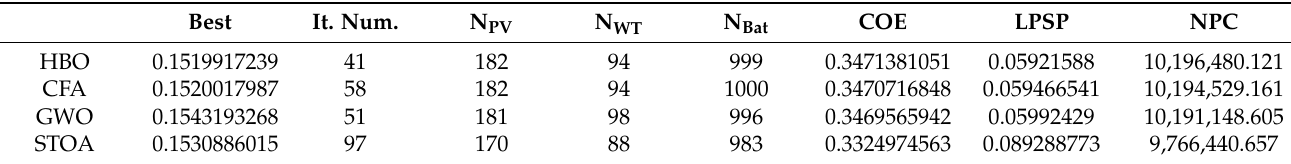
Table 9. The optimization properties for the proposed hybrid system based on using HBO, CFA, GWO and STOA for an isolated